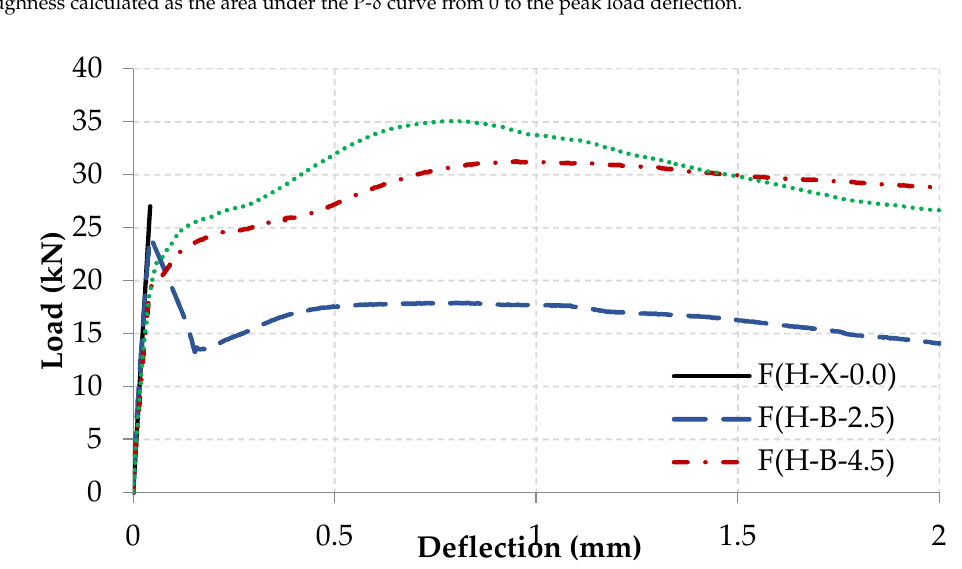
Figure 7. Load-deflection (P- δ ) curves for full depth specimens.